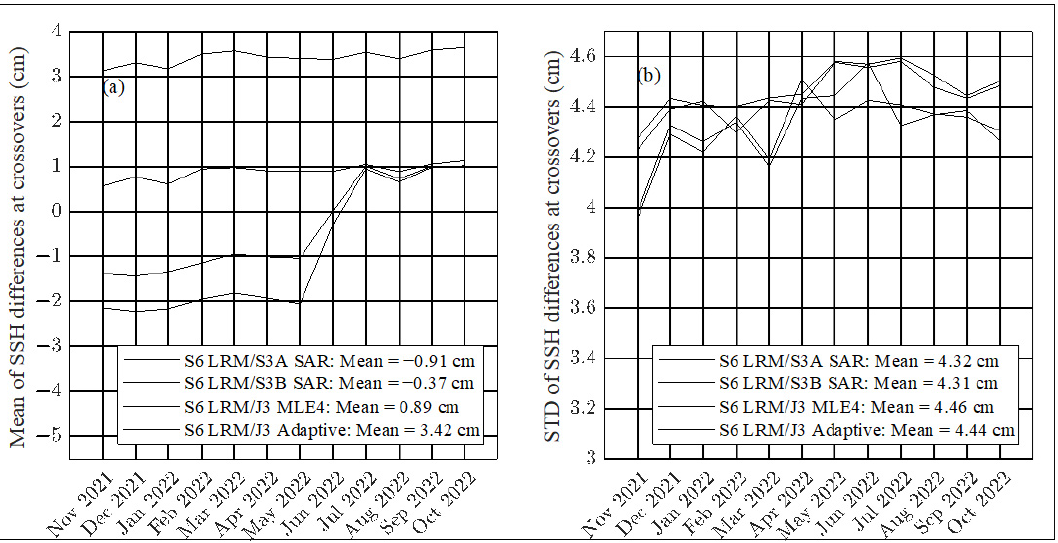
Figure 7. Month per month monitoring of the ( a ) mean and ( b ) STD of the SSH differences computed at Sentinel-6 (LRM) and Sentinel-3A/B and Jason-3